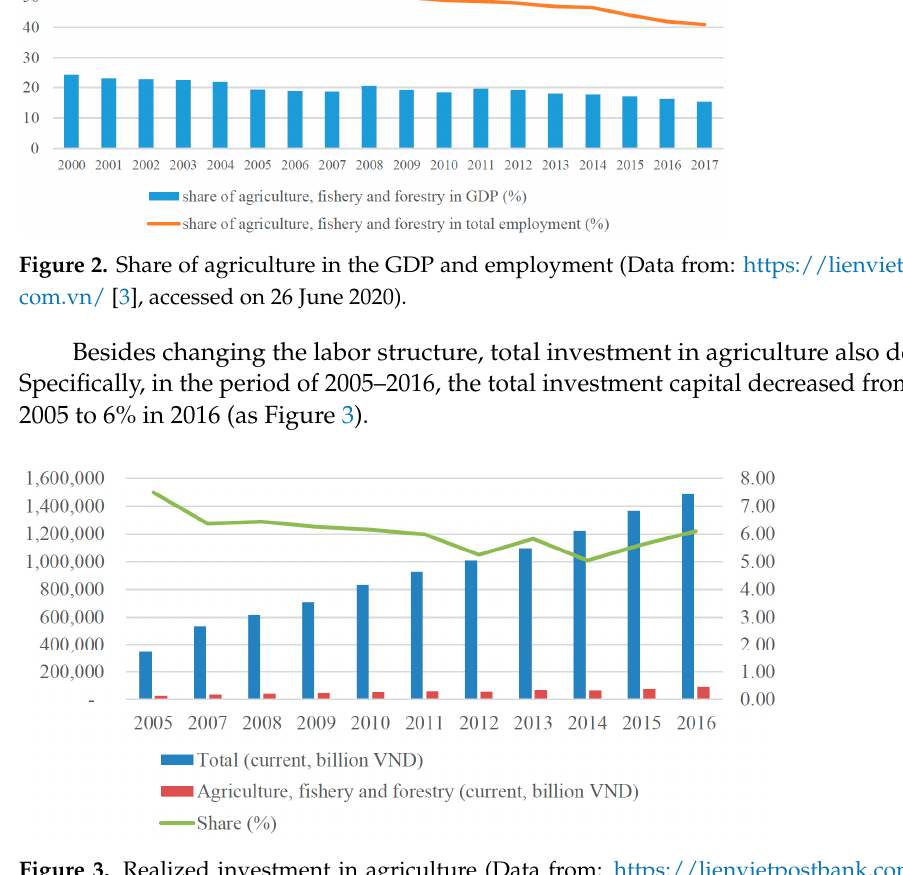
Figure 3. Realized investment in agriculture (Data from: https://lienvietpostbank.com.vn/ [3], accessed on 26 June